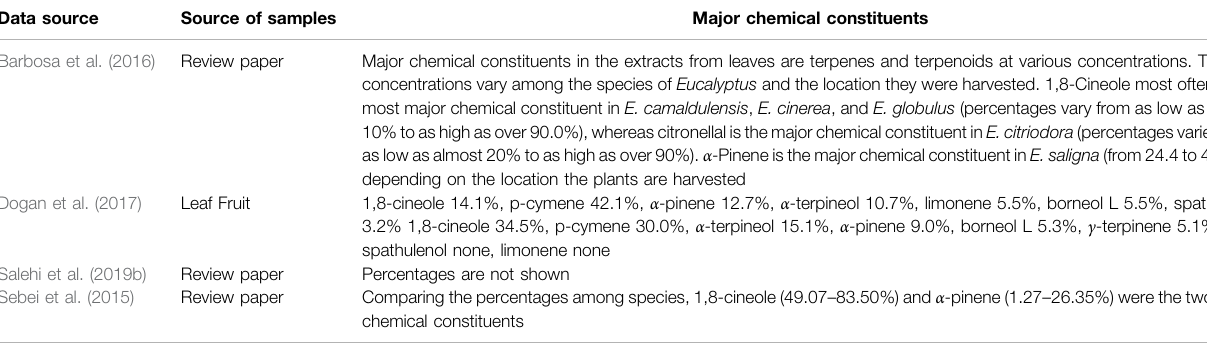
TABLE 2 | Major chemical constituents of eucalyptus plants and essential oils.